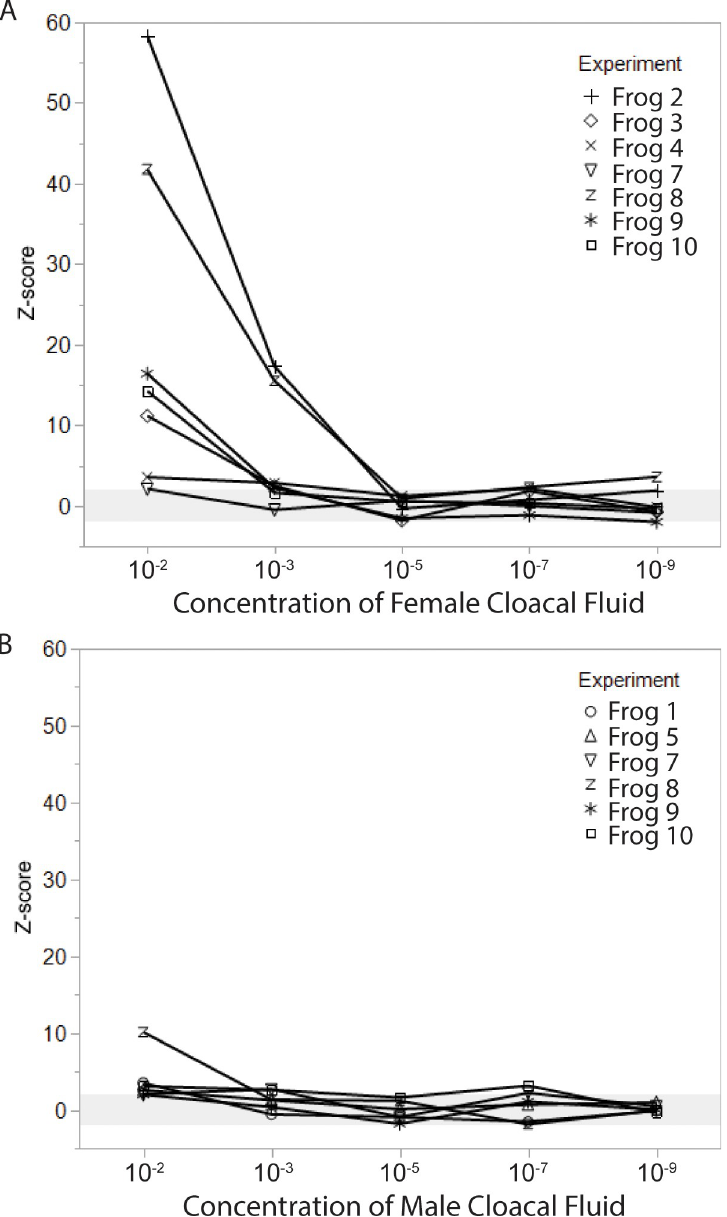
Fig 5. EOG responses to different concentrations of cloacal fluids from female and male conspecifics, represented as z-score relative to cloacal control stimuli. (A) EOG amplitudes in response to female cloacal fluids were robust at 10 − 2 concentration, and declined at lower concentrations, with the detectability threshold (z � 2) falling between 10 − 3 and 10 − 5 for most animals. (B) EOG amplitudes to male cloacal fluids were far smaller, with a detection threshold between 10 − 2 and 10 − 3 for most